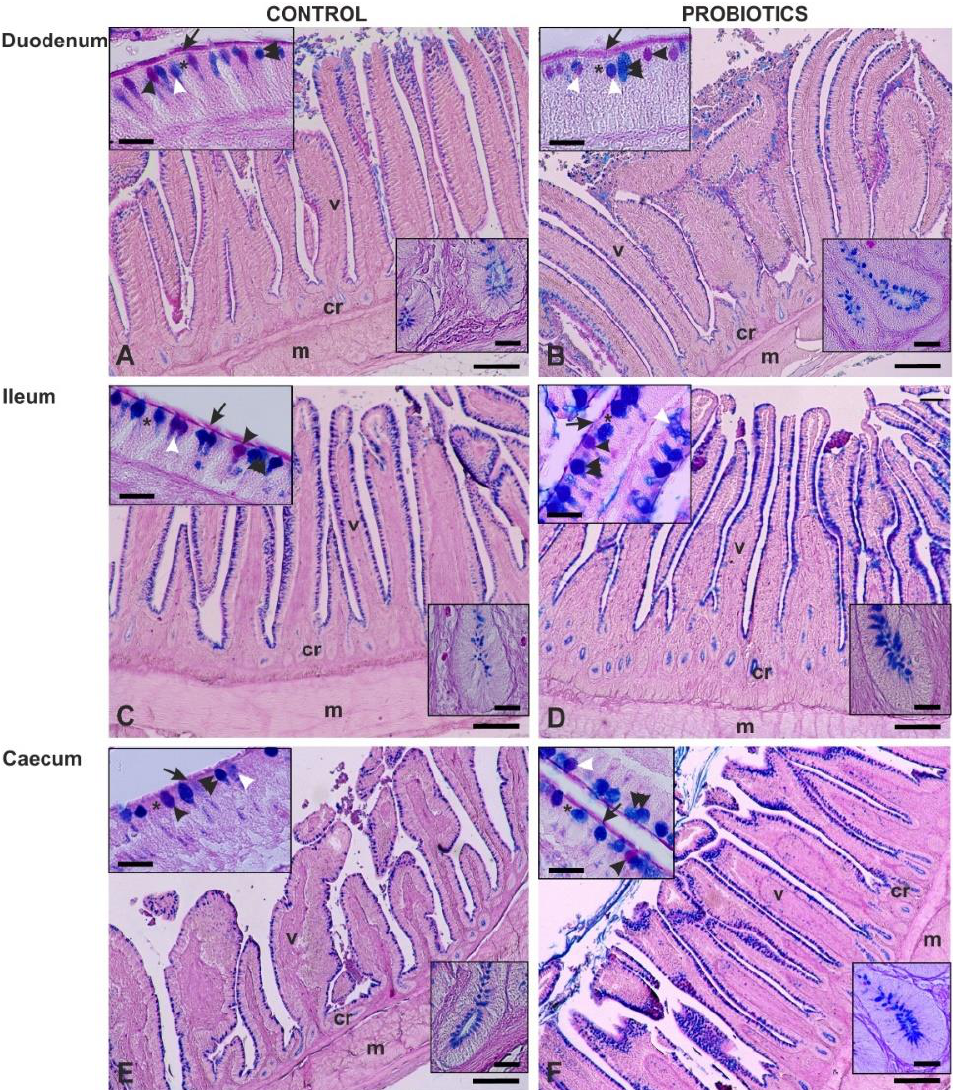
Figure 2. Alcian Blue pH 2.5 (AB2.5) and PAS staining of guinea fowl duodenum ( A , B ), ileum ( C , D ) and caecum ( E , F ). A,C,E: C samples; B,D,F: P samples. Most of the goblet cells exhibit AB 2.5 positivity (blue), whereas few goblet cells were either only PAS-positive (magenta) or both PAS- and AB 2.5-positive (violet). Insets show details of villus (top) and crypt (bottom) epithelial cells. cr, crypt; m, muscularis wall; v, villus; arrow, luminal surface; asterisk, epithelial cell. Black arrowhead, PAS-positive goblet cells; double arrowhead, AB2.5-positive goblet cells; white arrowhead, mixed stained goblet cells. Scale bars: A–F, 200 µm. Insets: A–F, 20 µm.